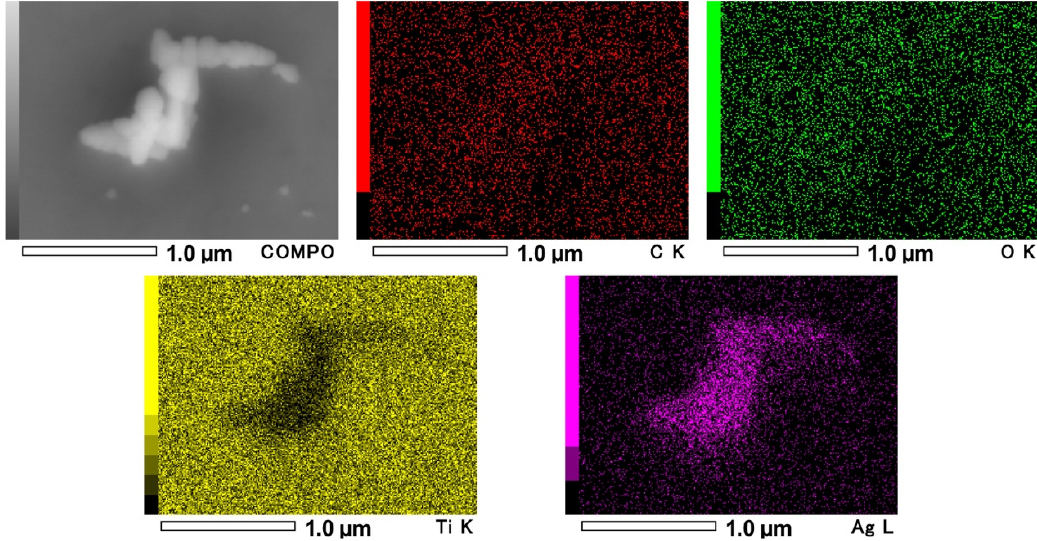
Figure 2. Energy-dispersive X-ray spectroscopy (EDS) mapping images of nano-Ag coating. COMPO: reflection electron composition image; C: carbon; O: oxygen; Ti: titanium; Ag: silver. The aggregation of the nano-sized particle and the composition was Ag.